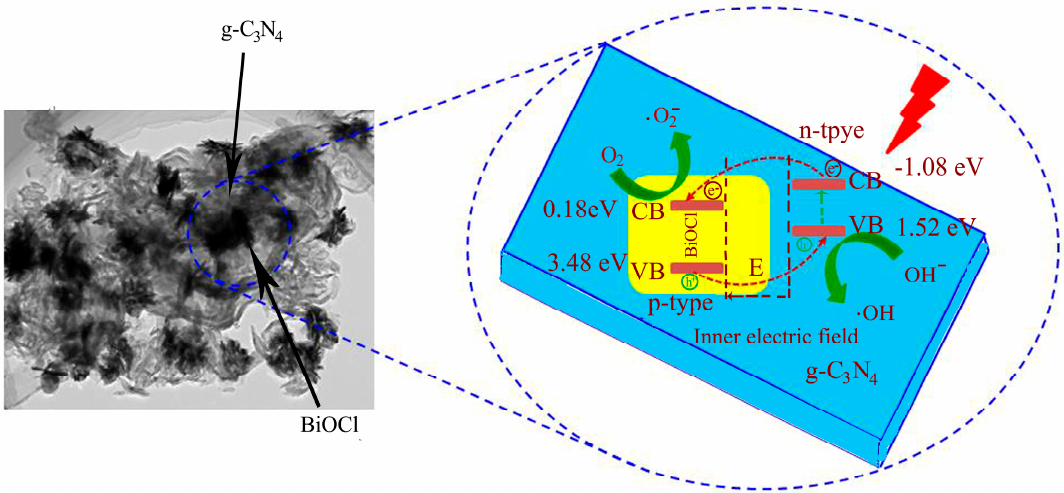
Figure 11. Schematic illustration of the charge transfer process over g-C 3 N 4 /BiOCl heterostructure.